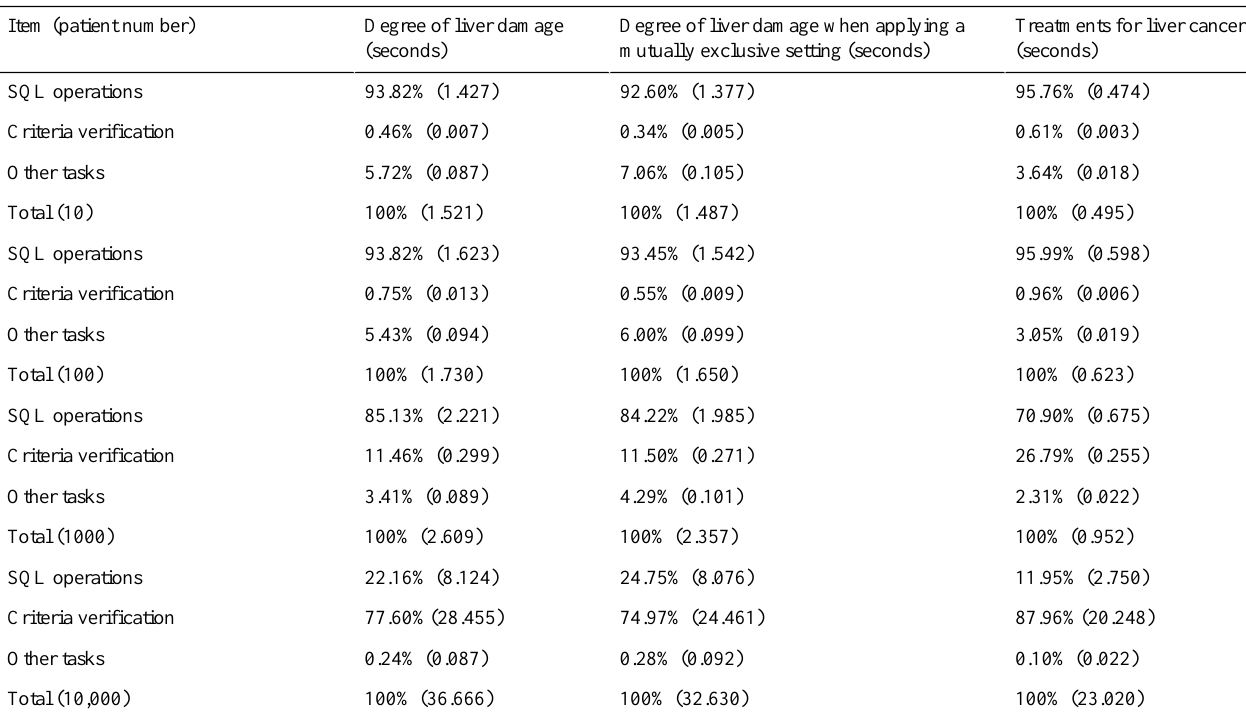
Table 3. The performance in time of the system in experiment with three query tasks.